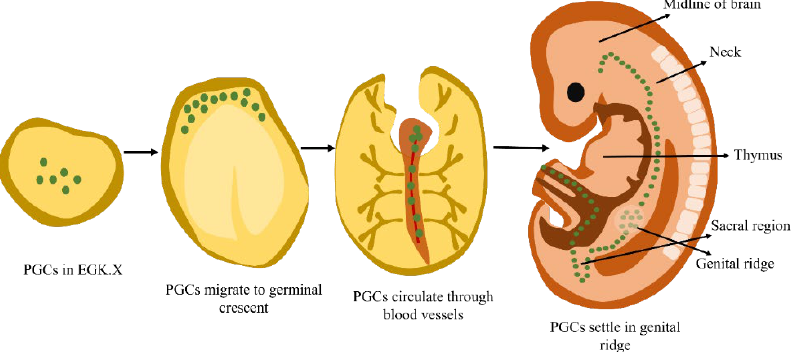
Figure 2. Chicken PGCs are found in the zona pellucida region’s core, migrating via the vascular system and germinal crescent before settling in the genital ridge, which is also the site of the bird’s eventual gonads (modified from Mozdziak and Petitte [29]).